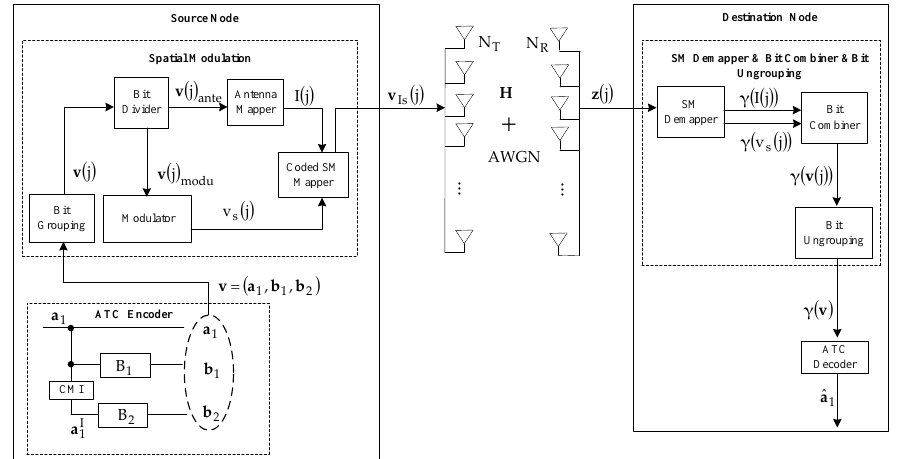
Figure 4. Non-cooperative asymmetric turbo-coded spatial modulation (ATC-SM) scheme with the code matched interleaver (CMI).